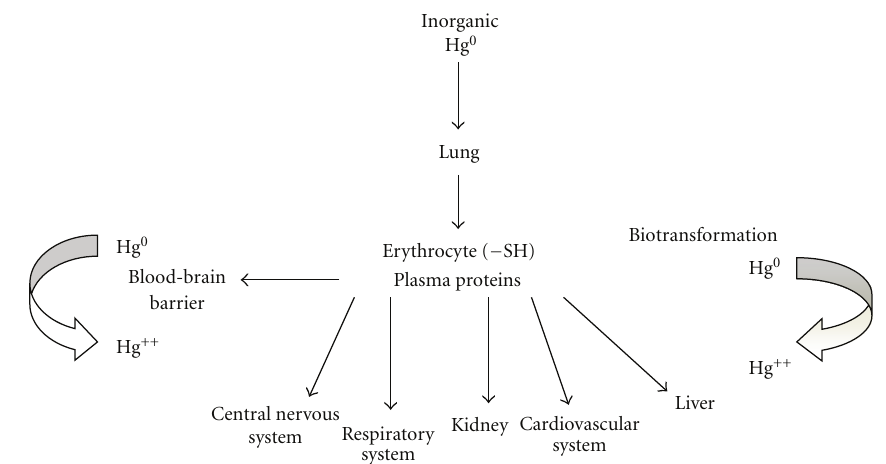
Figure 1: Scheme showing the entry of elemental mercury in organisms and their distribution in di ff erent organs.